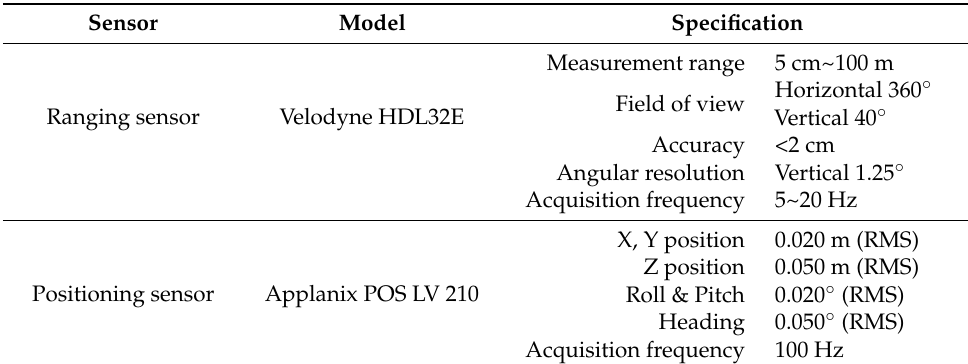
Table 1. Sensor specifications of the MMS.